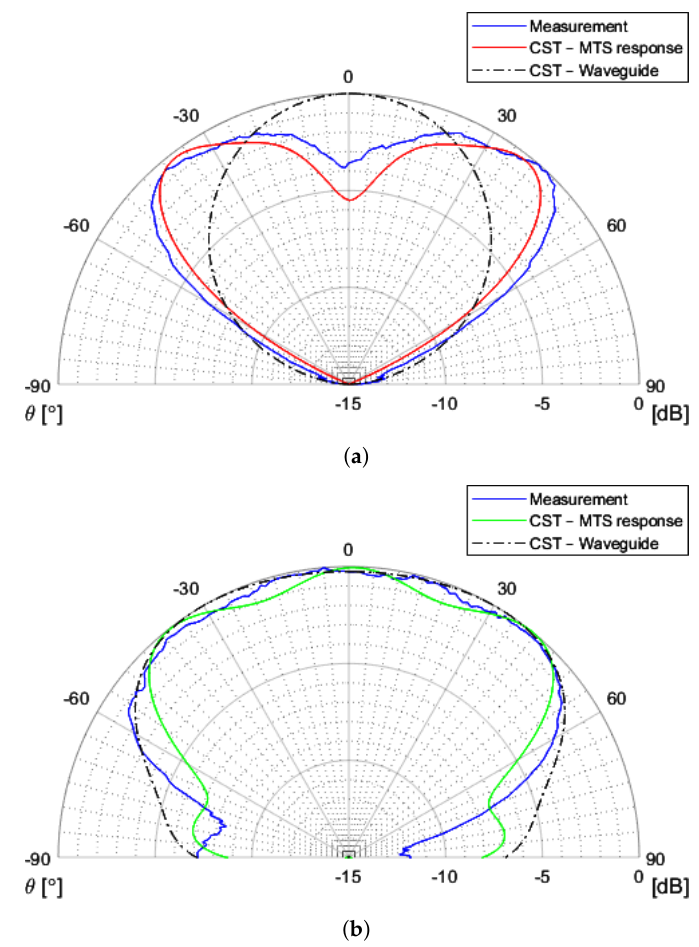
Figure 15. Simulated and measured response of a produced semi-cylindrical MTS, with a WR90 waveguide opening as the source. Normalized to maximum directivity. ( a ) y -oriented waveguide opening; ( b ) x -oriented waveguide